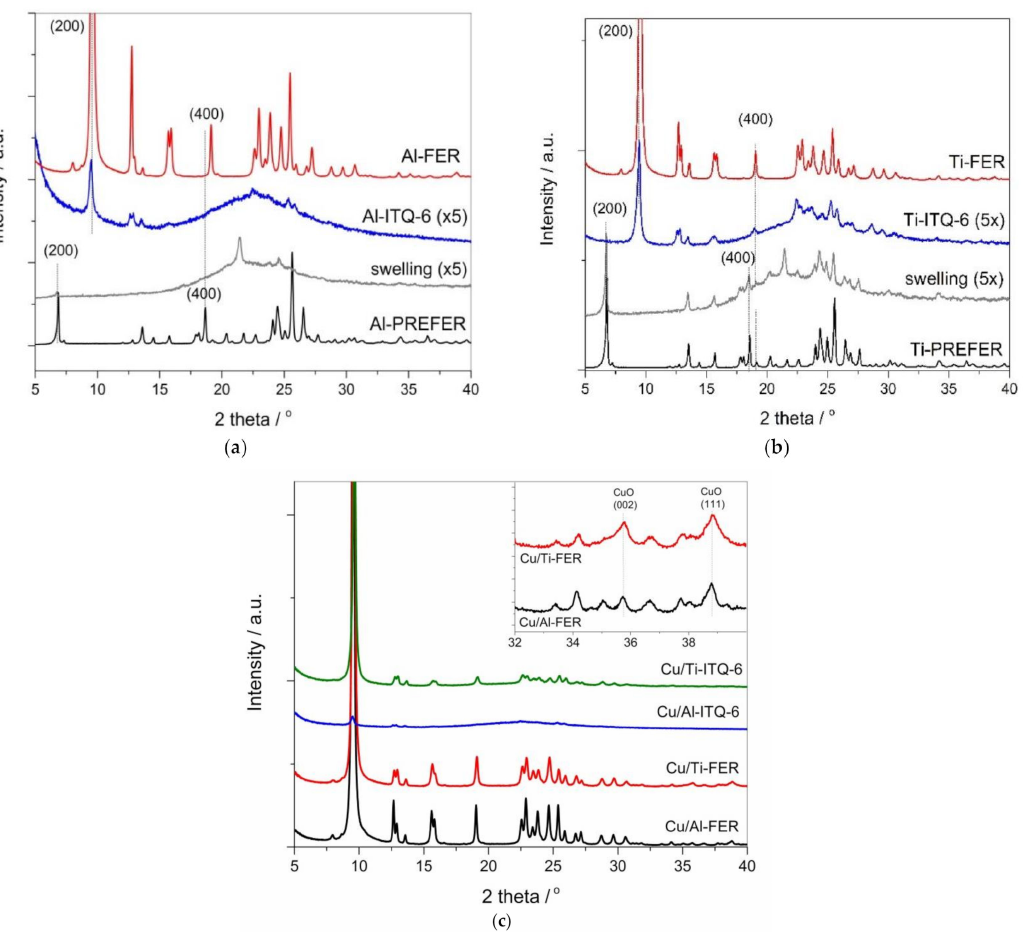
Figure 1. X-ray di ff ractograms recorded for the ferrierite-based samples (PREFER, swellen PREFER, delaminated ITQ-6 and FER) with aluminum ( a ) and titanium ( b ) incorporated into the zeolite framework as well as their modifications with copper ( c